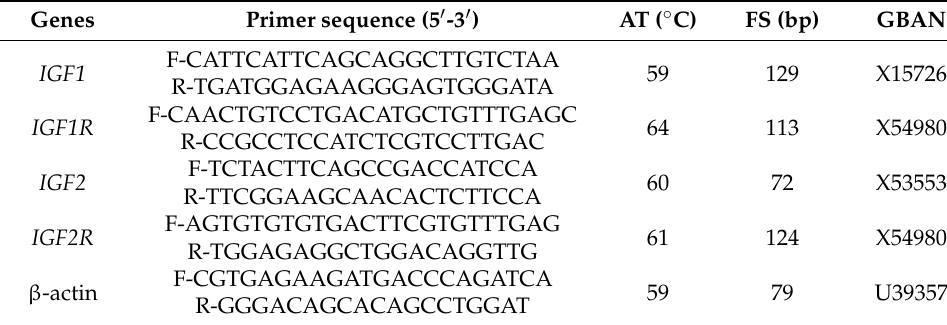
Table 1. Details of primer pairs used for bovine oocyte RT-PCR reactions.